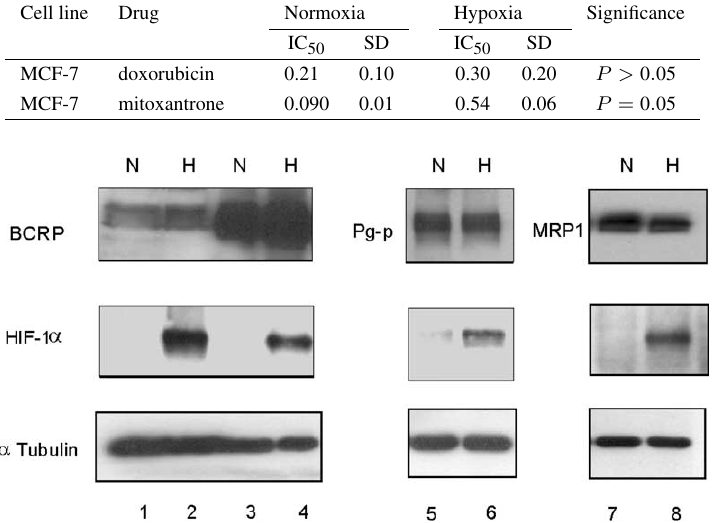
Fig. 2. Western blot analysis of protein levels of MDR1, BCRP, MRP1 and as control for hypoxia HIF-1 α . α -tubulin is used as loading control. Cells were incubated under hypoxia and normoxia during 72 hours, after which cells were lysed and MDR expression was analysed. Lane 1: MCF-7 under normoxia, 2: MCF-7 under hypoxia, 3: MCF-7 MR, overexpressing BCRP, under normoxia, 4: MCF-7 MR under hypoxia, 5: MCF-7 DOX40 overexpressing P-gp, under normoxia, 6: MCF-7 DOX40 under hypoxia, 7: SW1573 2R120, overexpressing MRP1, under normoxia, 8: SW1573 2R120 under hypoxia.